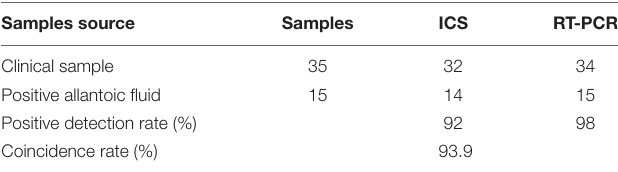
TABLE 3 | Comparative experimental results from ICS and